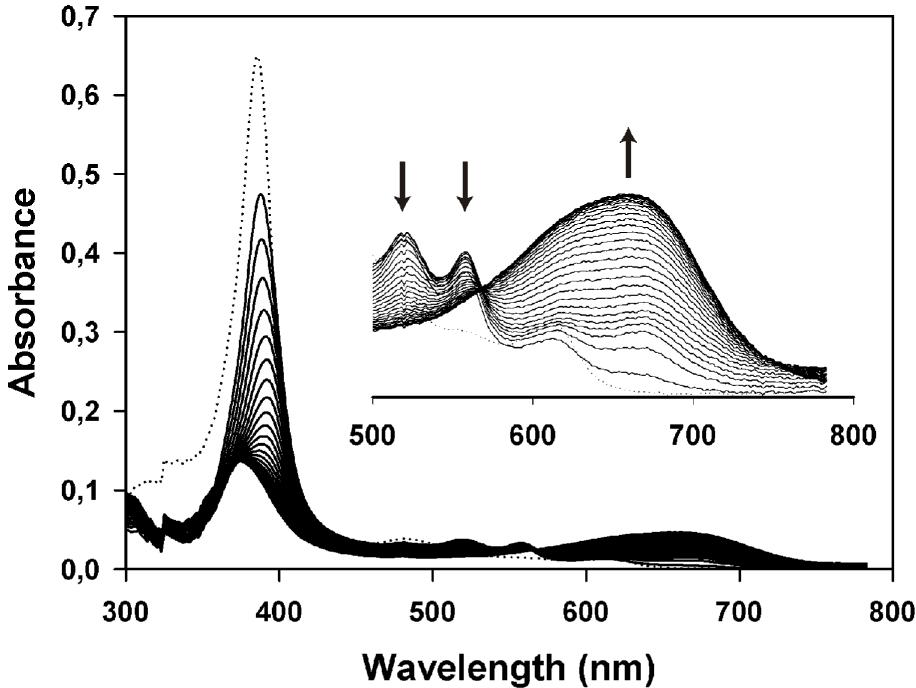
Fig 2. Heme turnover by TAT-LepHO in the presenceof TAT-LepFNR. Time dependentabsorption spectra of TAT-LepHO before (dotted line) and after the addition of 0.5 μ M TAT-LepFNR in the presenceof 300 μ M NADPH and 0.1 mg/ml catalaserecordedat 1 min intervals (solid lines). As the reaction proceeded, the TAT-LepHO Soret peak at 403 nm decreased, and a broad absorption band with maximum near 680 nm (biliverdin)appeared,indicating that TAT-LepHO channeledTAT-LepFNR electrons to cleave heme and producebiliverdin.The inset shows an enlargement of the regionbetween500 and 800 nm.